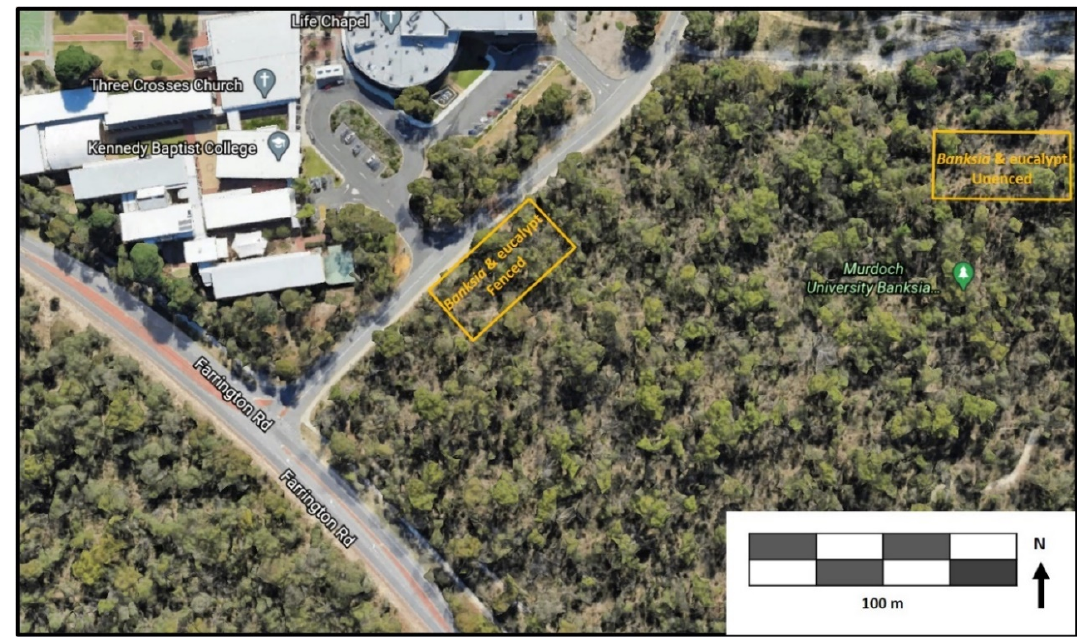
Figure A2. Locale of the transects for sampling understory structure adjacent to the fenced and unfenced recreational trails at Murdoch University (source: Google Earth [89]).